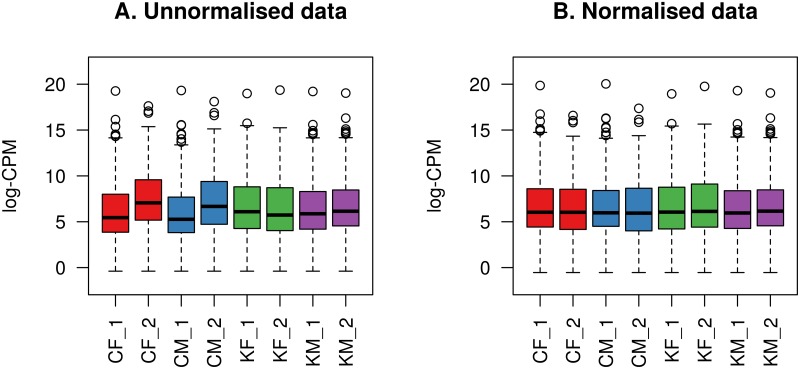
Boxplots of log-CPM values showing expression distributions.A: Filtered unnormalised data for each sample. B: Filtered and TMM normalised data for each sample. The line dividing the box represents the median of the data and top and bottom of the box shows the upper and lower quartiles respectively. The whiskers show the highest and lowest values, excluding outliers, which are show as circles.